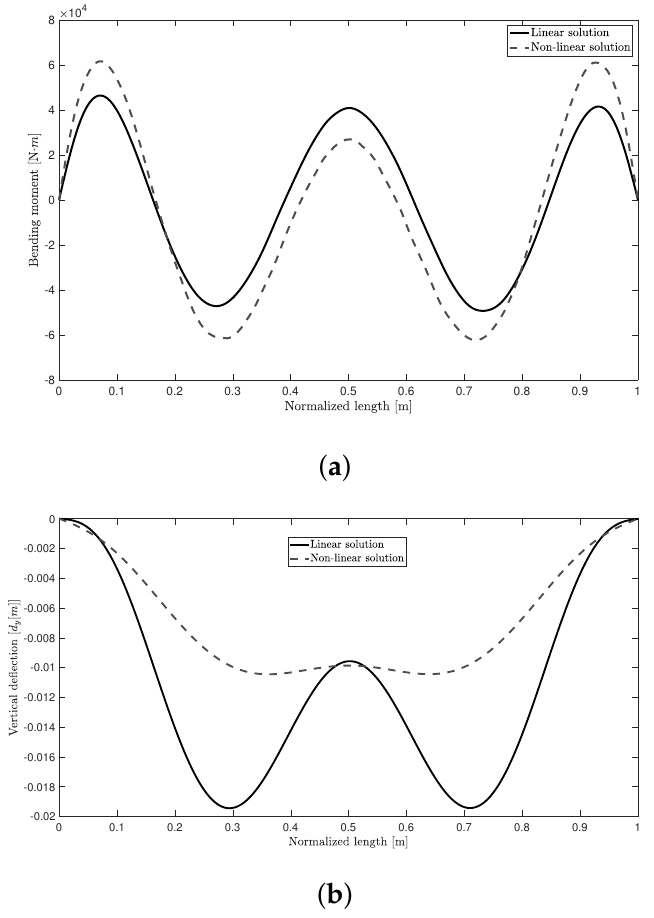
Figure 5. Bending moment and vertical deflection comparative for linear (solid line) and non-linear (dashed line) in the case in which the height H is fixed.